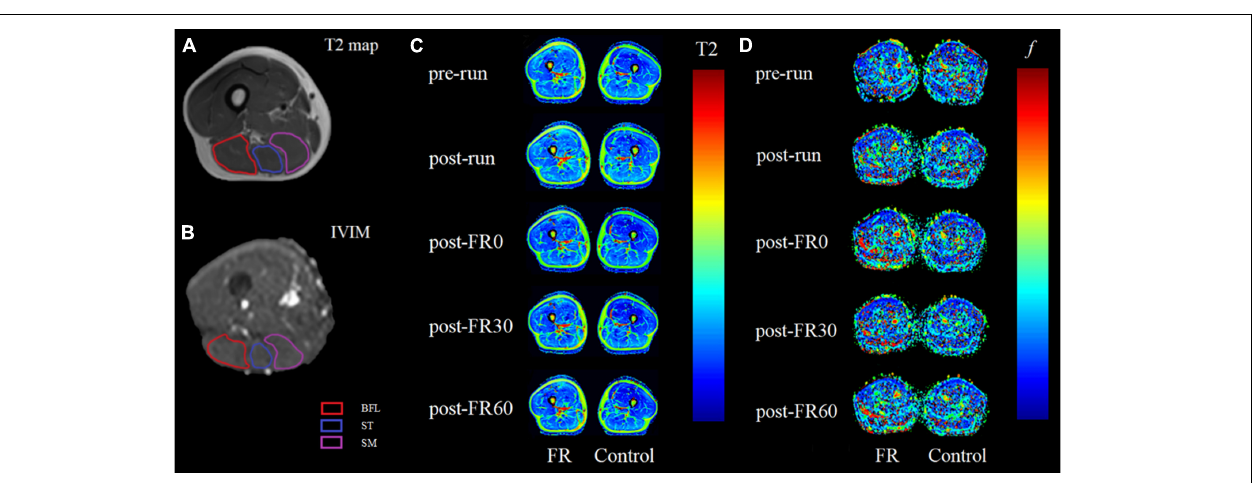
FIGURE 3 | Example magnetic resonance images for raw T2 (A) and raw intravoxel incoherent motion (IVIM) b0 images (B) images with region of interest outlined for biceps femoris long head (BFL), semitendinosus (ST) and semimembranosus (SM). Panels (C,D) are color-coded maps for T2 mapping and IVIM f at different time points, respectively, with images on the left side being the limb that received foam rolling intervention. Light colors on the color-coded maps indicate lower values. FR, foam rolling; pre-run, baseline; post-run, 2–3 h after half-marathon running; post-FR0, immediately following FR intervention; post-FR30, 30 min after FR; post-FR60, 60 min after